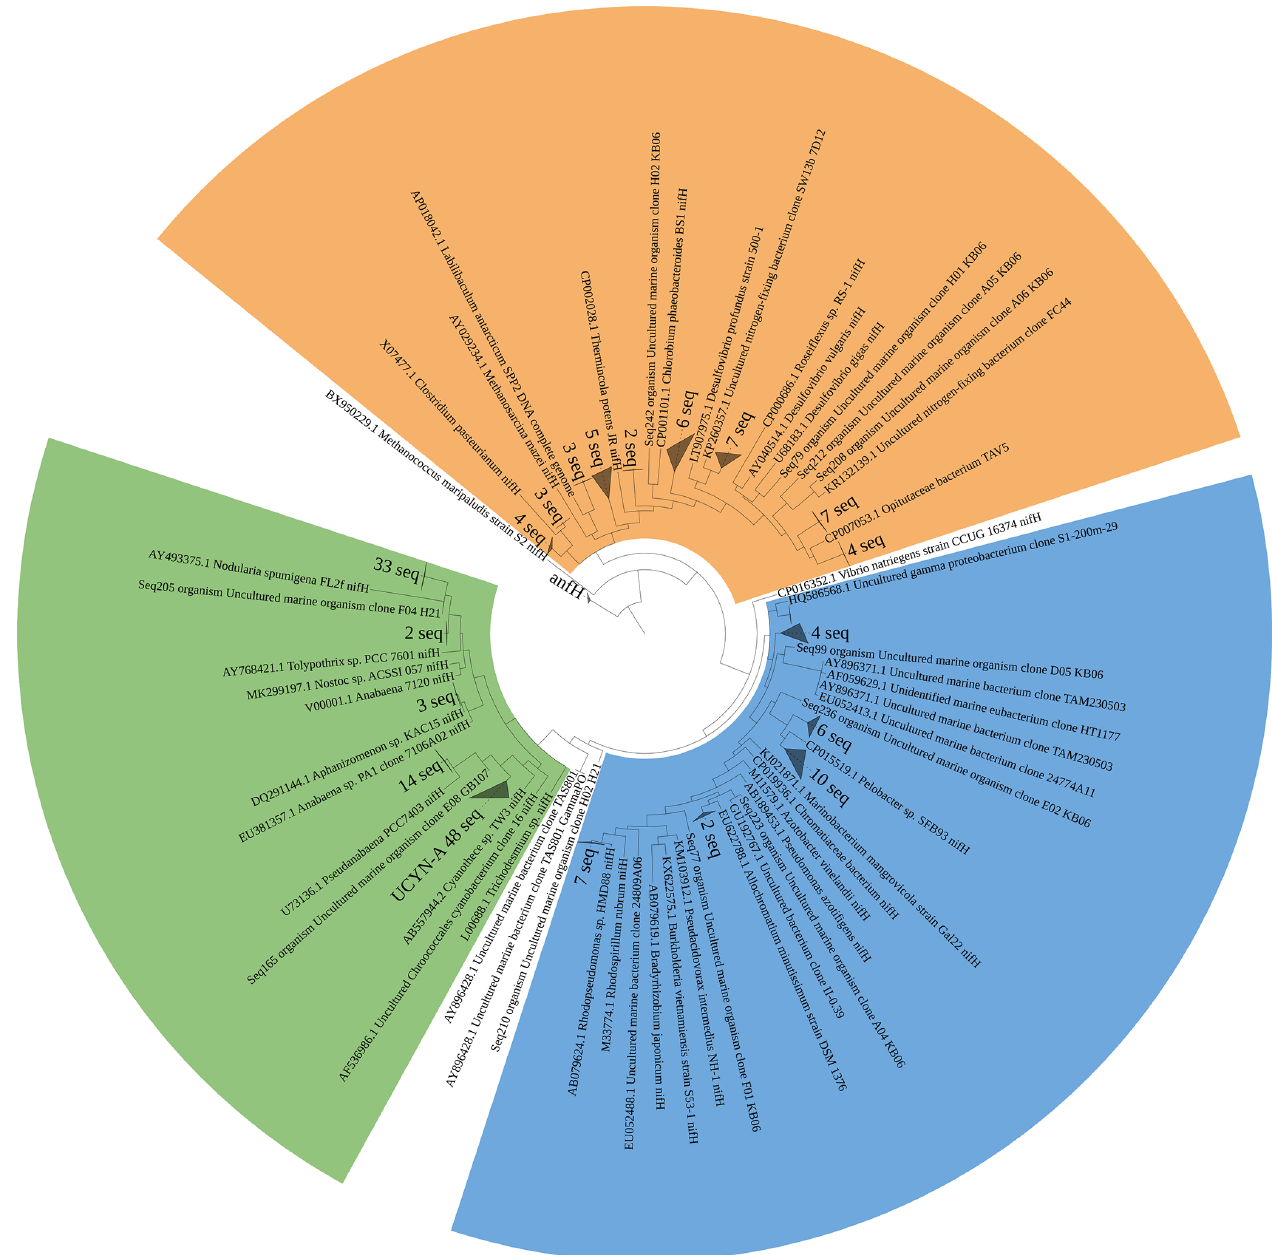
Figure 5. Maximum likelihood tree of nifH amplicons (321bp) identified by Sanger sequencing. Clusters identified are denoted as grey triangles, while identified individual sequences are denoted as Seq + NCBI submission ID. Cluster I cyanobacteria are shown in green, Cluster I Proteobacteria are shown in blue, and Cluster III diazotrophs are shown in